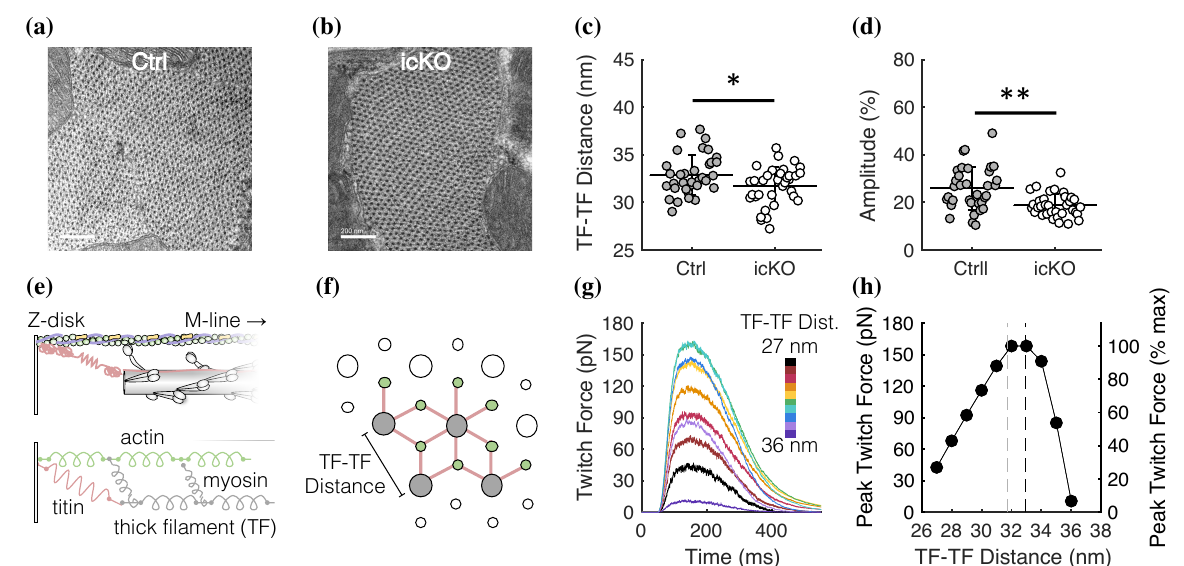
Figure 5. Myofilament lattice geometry determined by quantitative analysis of TEM images of papillary muscle cross-sections informs a spatially explicit computational model of a cardiac half- sarcomere. Example TEM images of a papillary muscle cross-section from a control ( a ) and an icKO ( b ) heart. Scale bar is 200 nm. ( c ) Average thick filament (TF) center-to-center separation